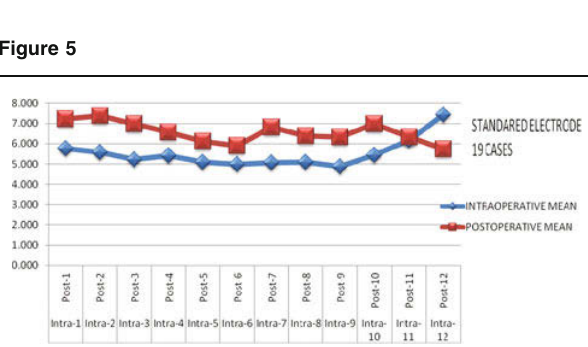
Mean of each active electrode impedance measured in patients intraoperatively and 1 month postoperatively using Mid Scala elec- trode.